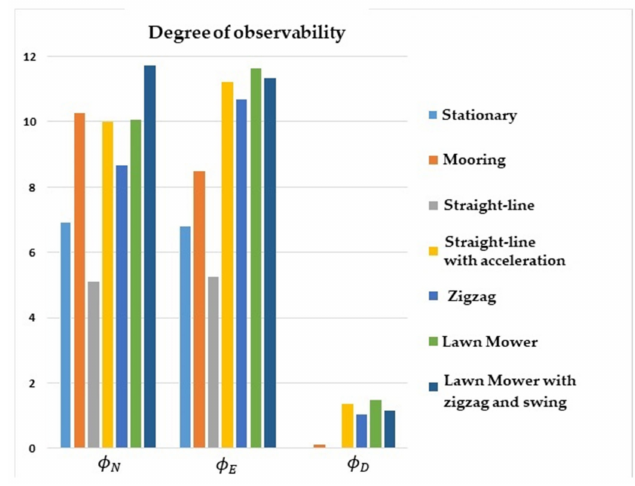
Figure 1. Degrees of observability of the attitude errors. INS/GPS/DVL/PS integration.